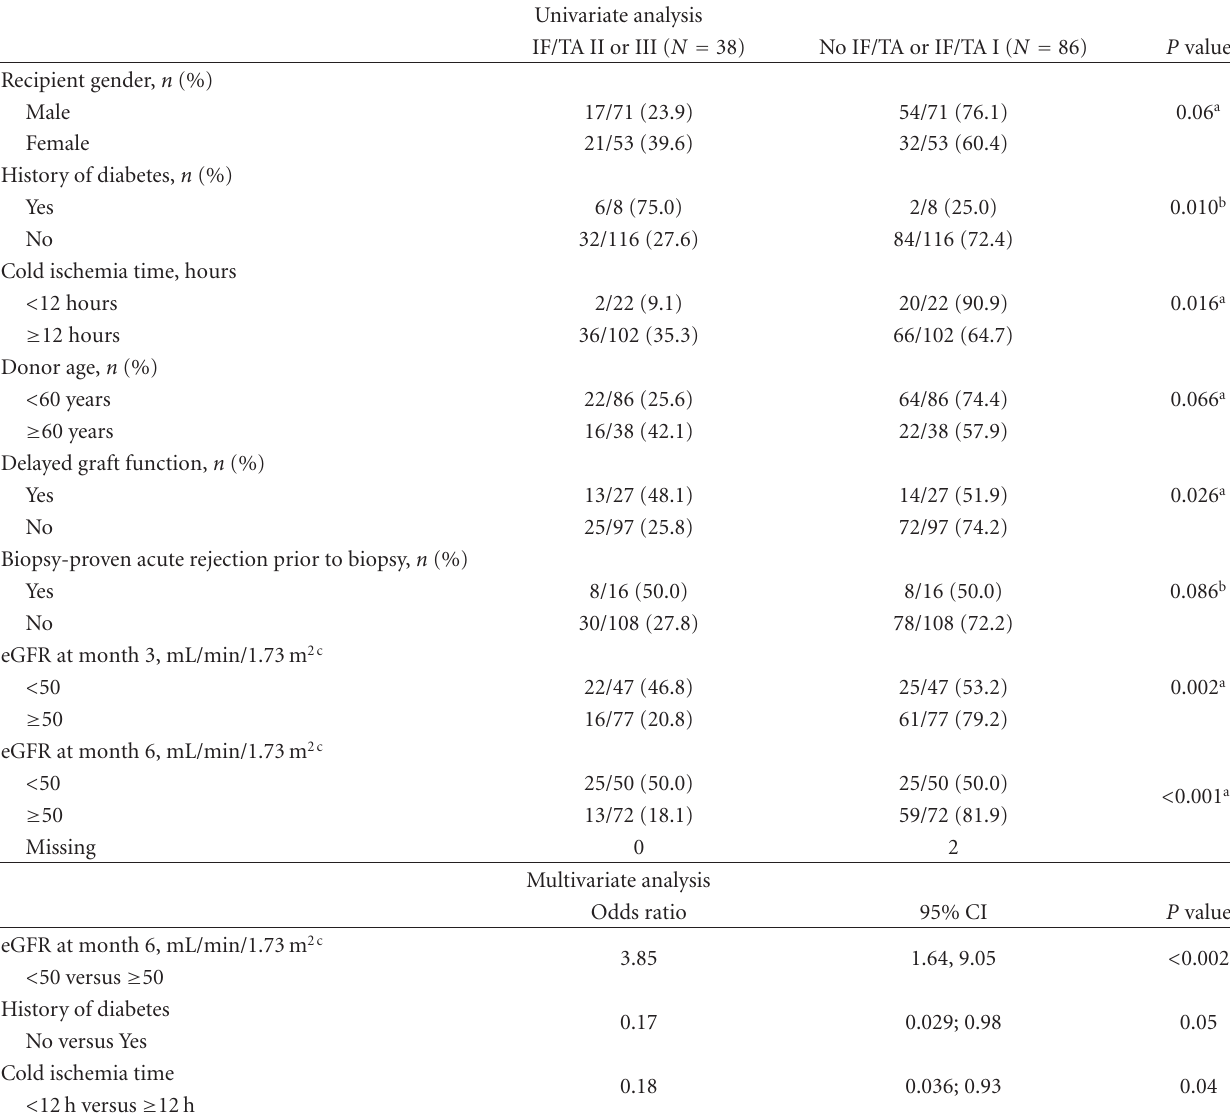
Table 5: Univariate and multivariate analysis of factors associated with IF/TA grade II or III on central biopsy reading for surveillance and diagnostic biopsies. All factors on univariate analysis showing an association ( P < 0 . 1) are shown in the table and were included in the multivariate